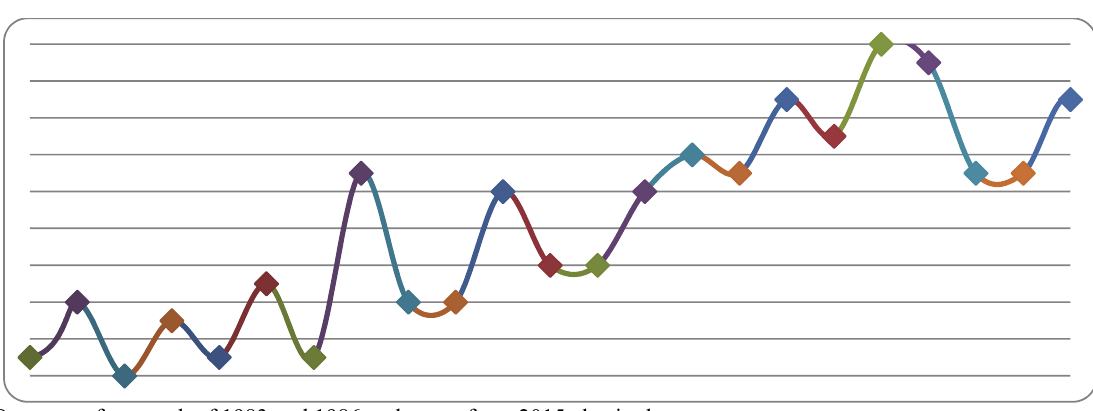
Fig. 1. Number of Life Insurance Efficiency Studies